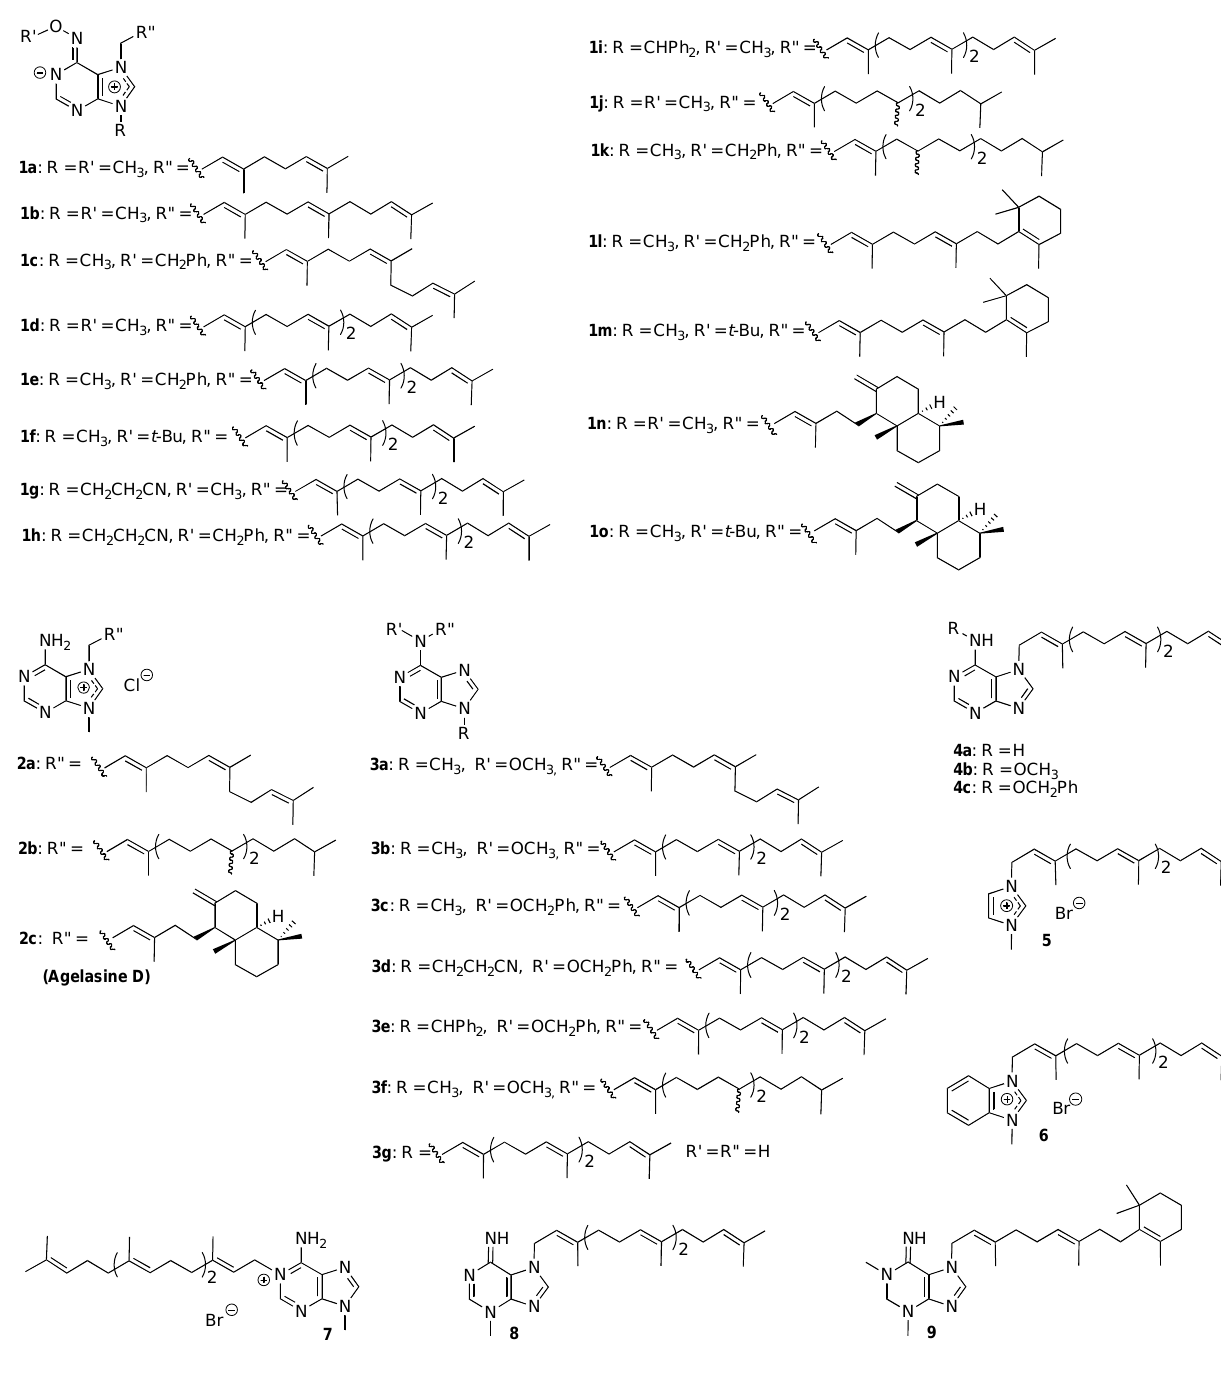
Figure 1. Structures of the studied agelasine analogs 1 - 9